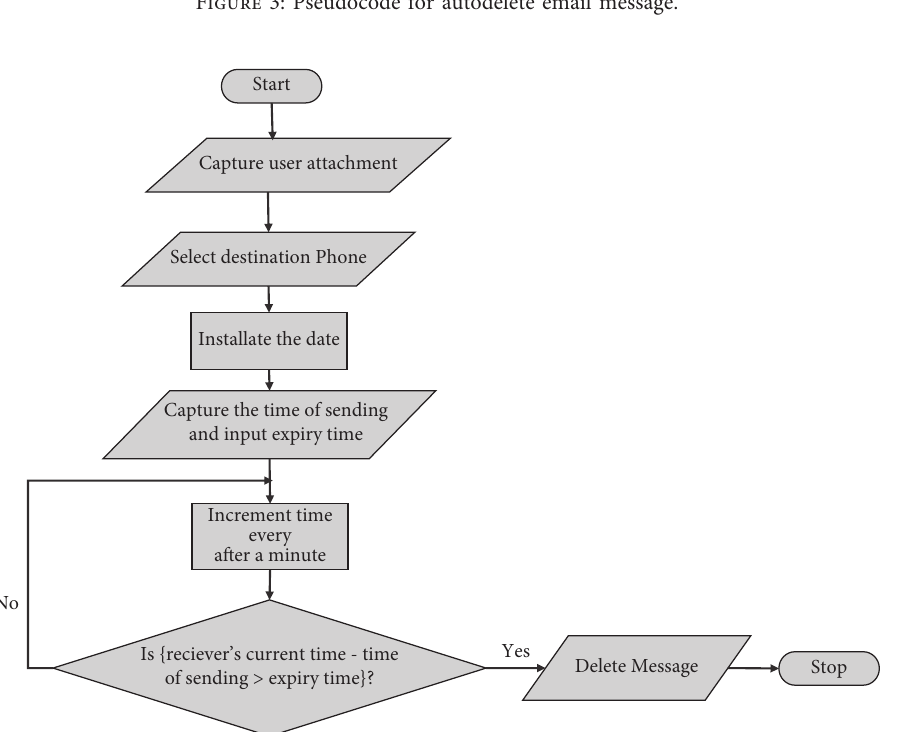
Figure 3: Pseudocode for autodelete email message.